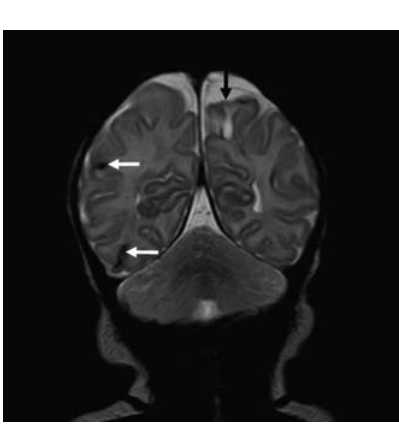
Figure 2. Head magnetic resonance image. Coronal TSE T2-weighted image demon- strates a cyst-like posterior paramedian parietal hemorrhagic contusion (black Figure 3. Full body magnetic resonance imaging angiogram image. Coronal maximum arrow) and parieto-occipital and tem- intensity projection image in portal venous phase depicts a large vein (white arrow) aris- porobasal cortico-subcortical focal areas of ing from the left renal vein (black arrow) and draining in the portomesenteric junction low signal intensity (white arrows). (black arrowhead) consistent with an extrahepatic portosystemic